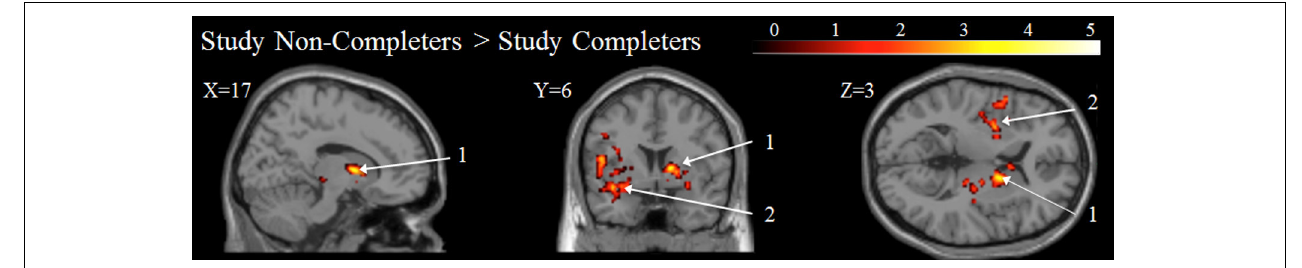
FIGURE 4 | Baseline BOLD for Study Completers vs. Study Non-completers. All color intensities are voxel-wise t -statistic, p < 0 . 05 FWE cluster-level corrected. Other conventions as in Figure 1 . (1) Putamen; (2)